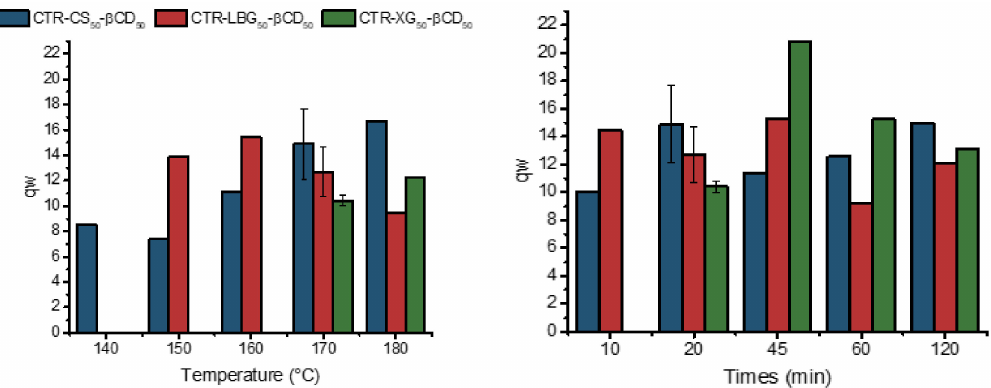
Figure 3. Swelling mass ratios for LBG, XG, and CS crosslinked hydrogels prepared using a 50 / 50 CD / PS feed ratio at di ff erent temperatures ( left ) and for di ff erent times at 170 ◦ C ( right ). (Error bars obtained using n = 3 for selected